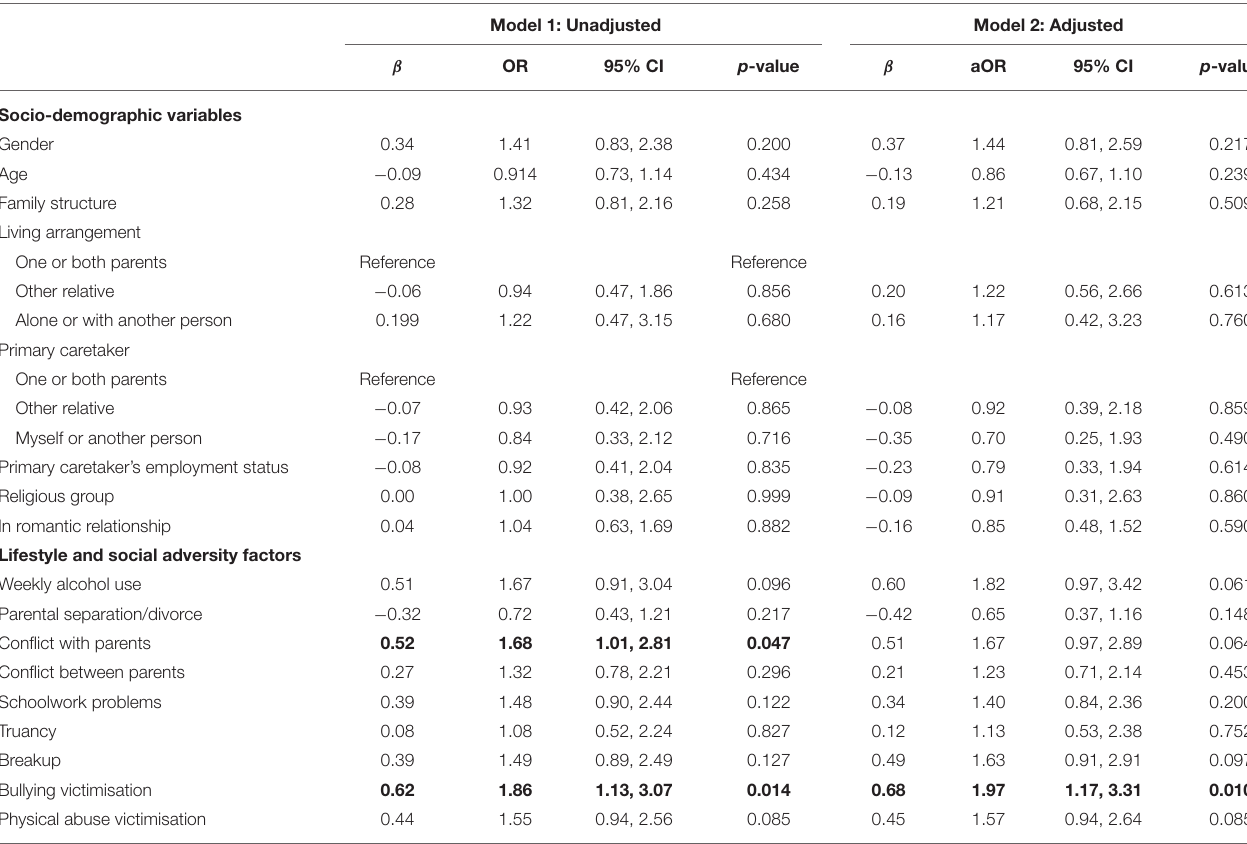
TABLE 4 | Multivariate associations: self-harm ideation. Model 1: Unadjusted Model 2: